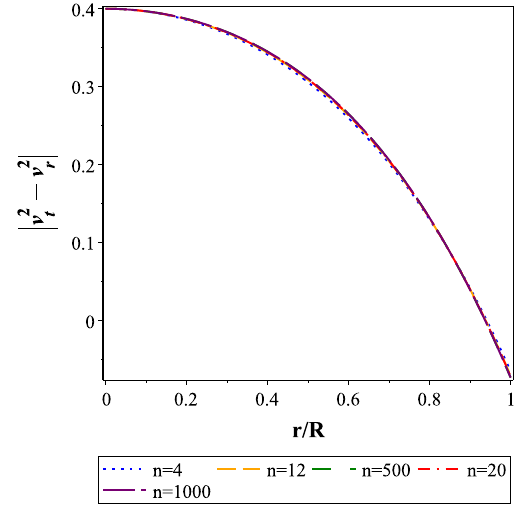
Fig. 7 Variation of the velocity difference ( | v 2 t − v 2 r | ) with respect to the radial coordinate ( r / R ). For purpose of plotting this figure , the numerical values of the constants for different parameters n are men- tioned in Table